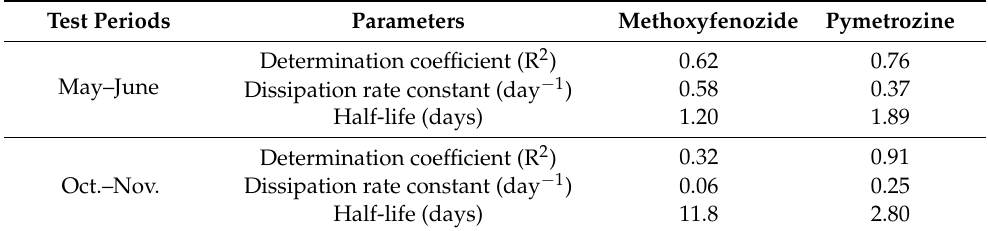
Table 3. The half-life and other statistical parameters for analyzed compounds in Chinese cabbage.